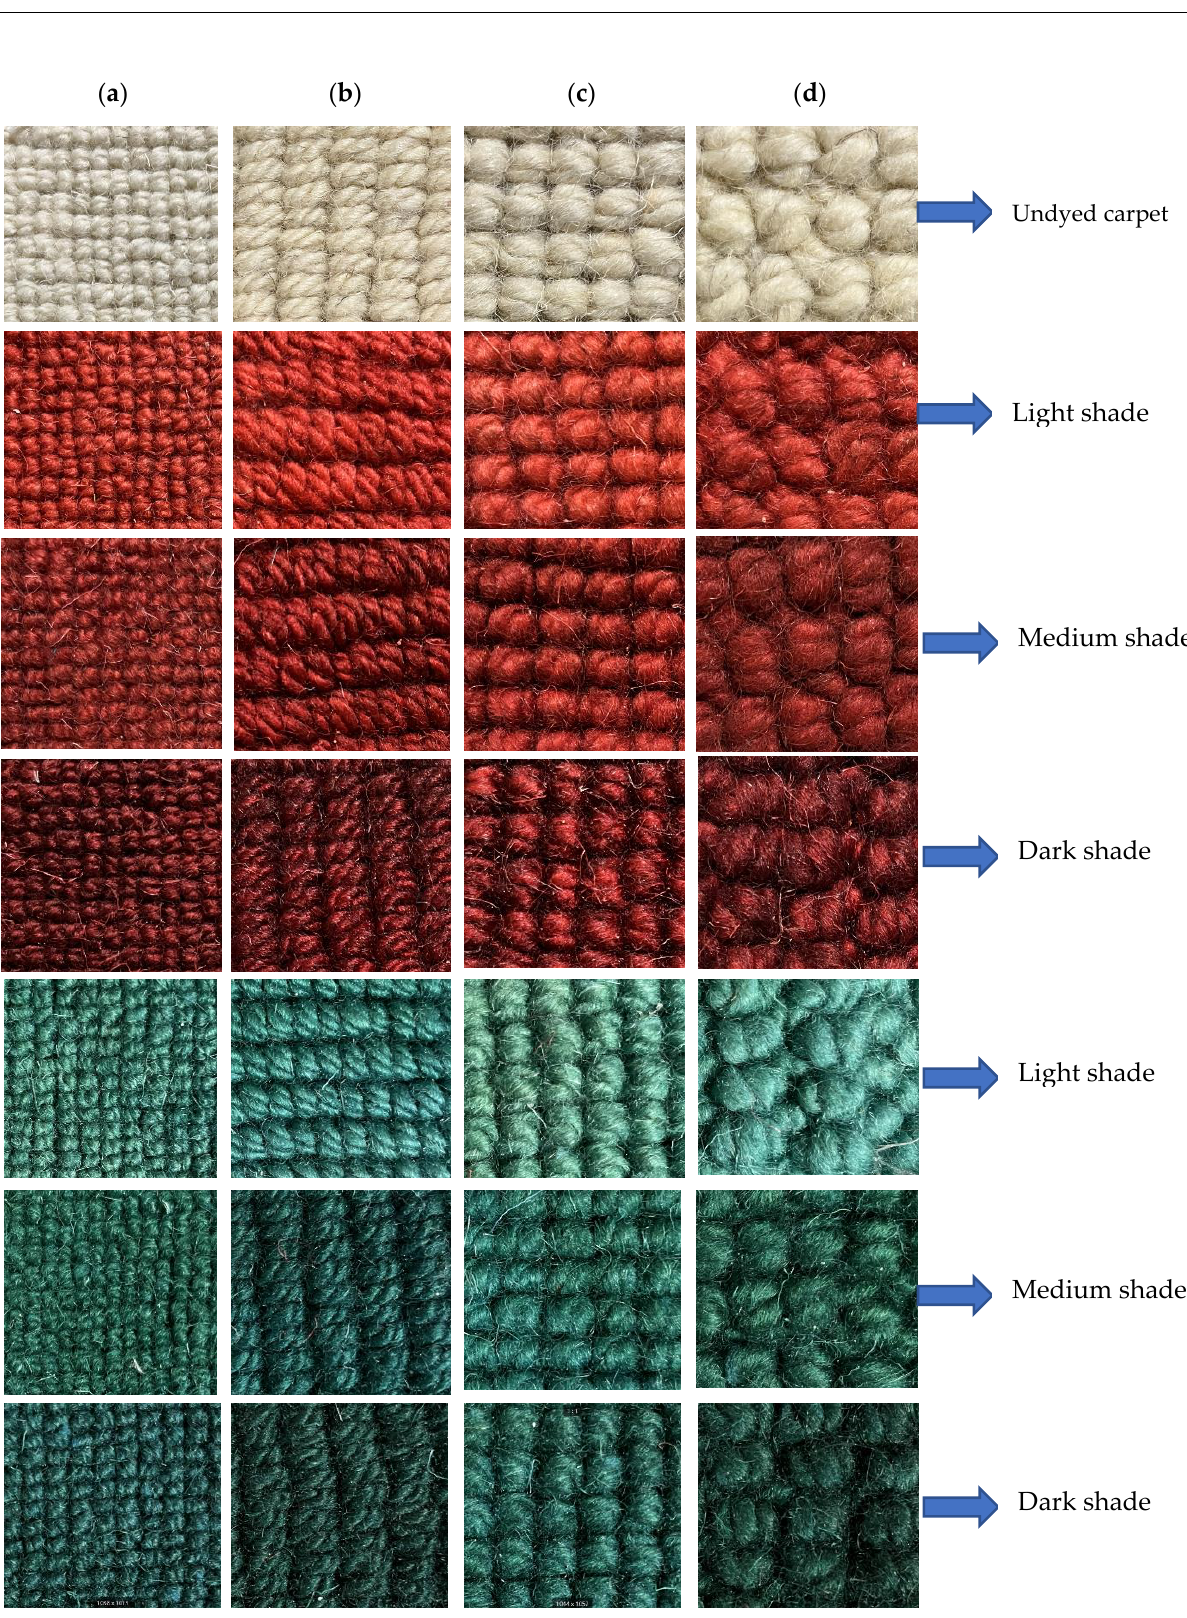
Figure 1. Undyed and Dyed carpets; images were taken under CWF illuminant ( a ) carpet 1, ( b ) carpet 2, ( c ) carpet 3, and ( d ) carpet 4 (pictures resolution: 4032 × 3024 pixels).